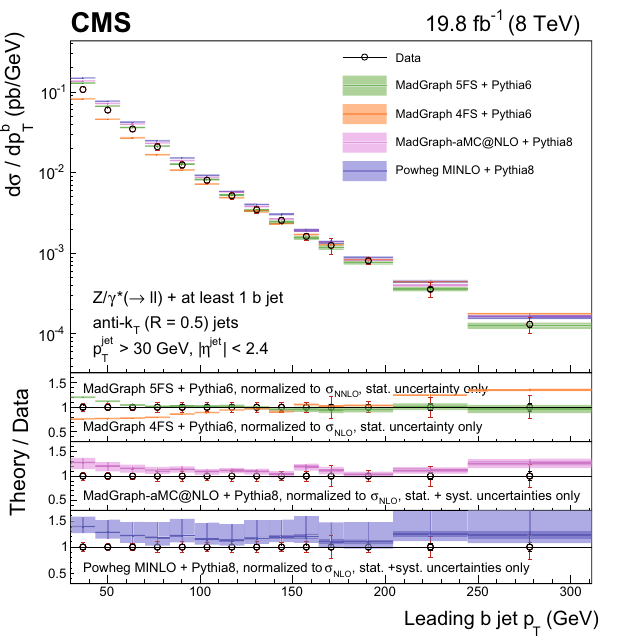
in the text. For each data point the statistical and the total (sum in quadrature of statistical and systematic) uncertainties are represented by the double error bar . The width of the shaded bands represents the uncertainty in the theoretical predictions, and, for NLO calculations, the inner darker area represents the statistical component only